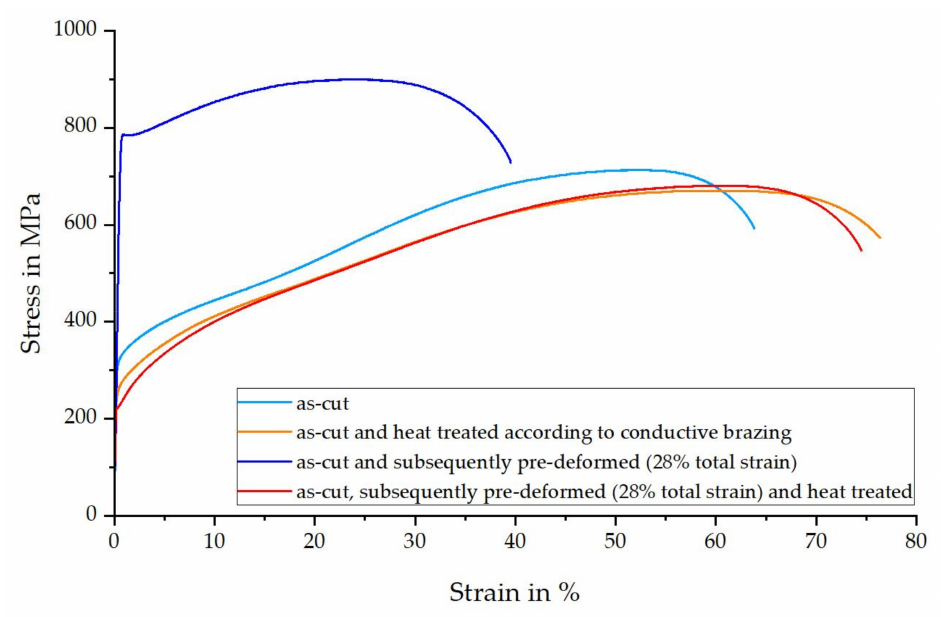
Figure 6. Stress–strain curves for different processing conditions from preliminary tests prior to fatigue